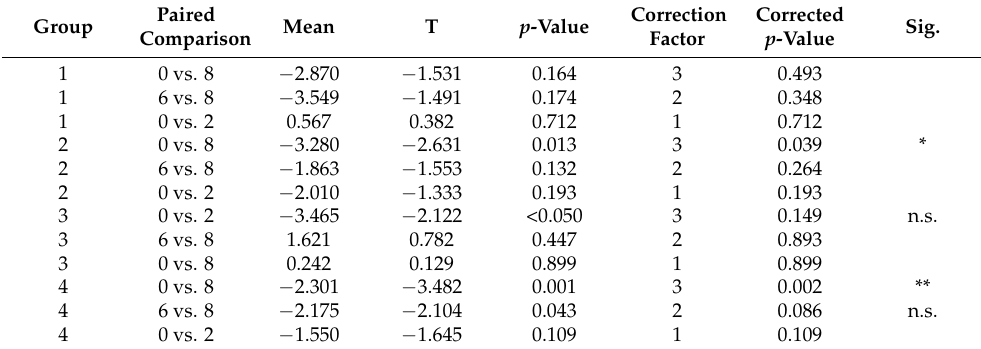
Table A3. Bonferroni–Holm-corrected p -values for DNase activity.